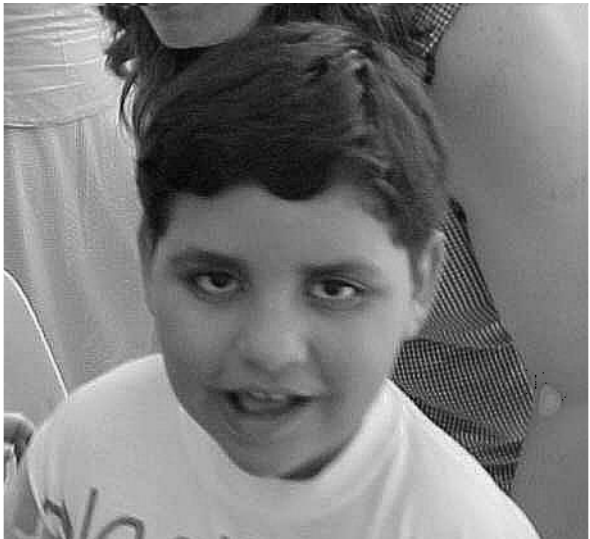
Figure 1 - Patient #5 at 7 years of